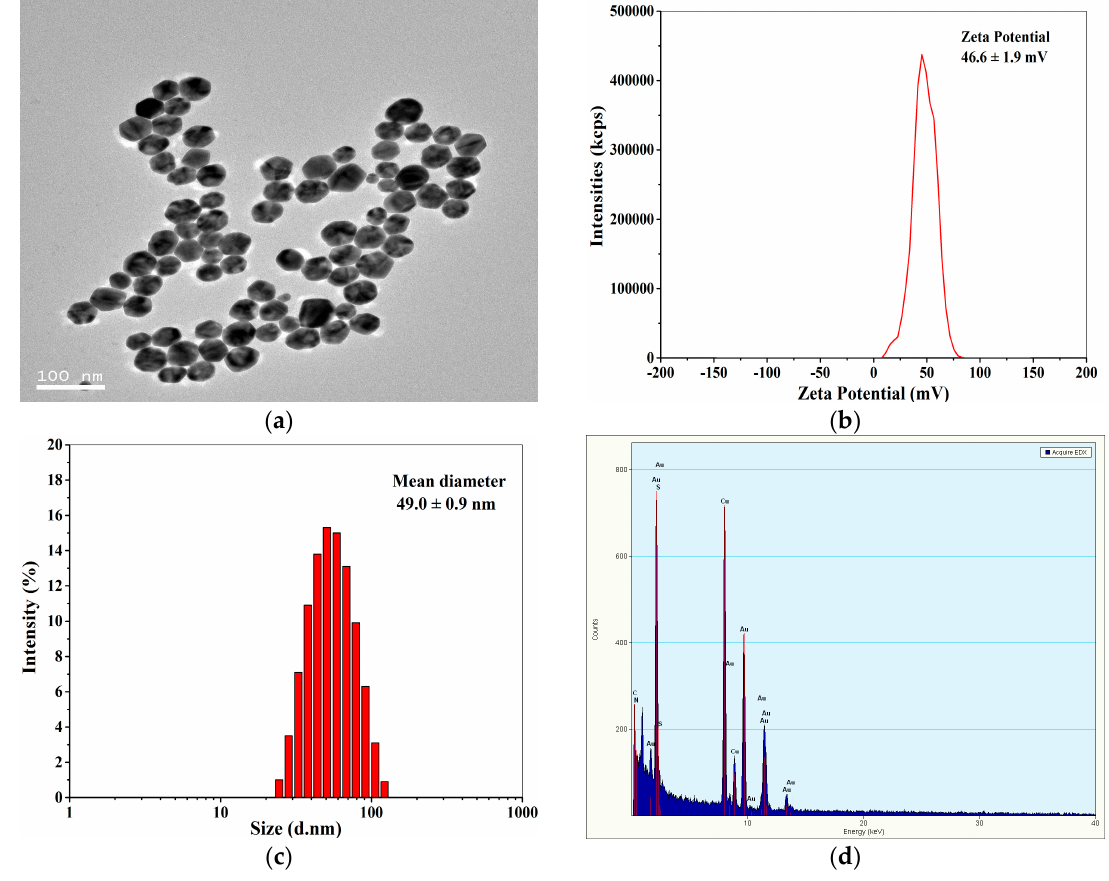
Figure 2. TEM image ( a ), Zeta potential distribution ( b ), size ( c ), and energy dispersive X-ray (EDX) spectrum ( d ) of the positively charged Au NPs.